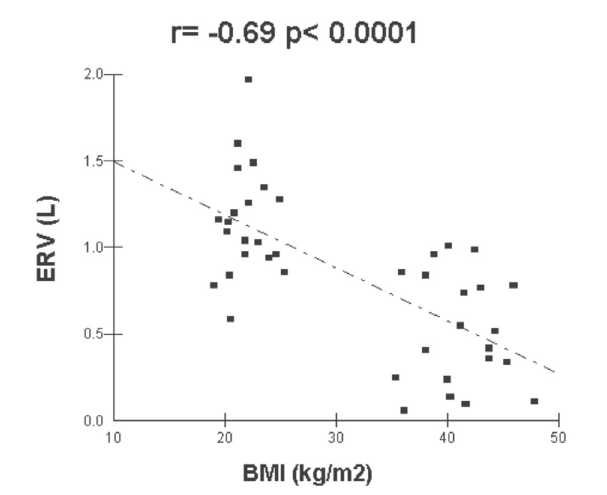
Figure 1 - Correlation between the body mass index (BMI) and the inspira- tory reserve volume (IRV)